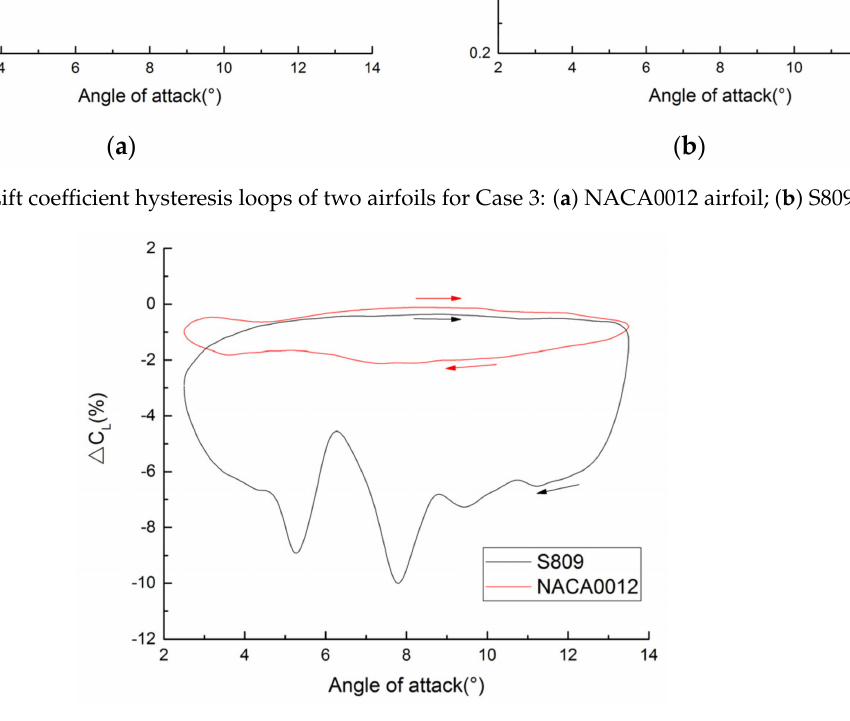
Figure 11. Relative increment loops of two airfoils after loading particles with a concentration of 1%.